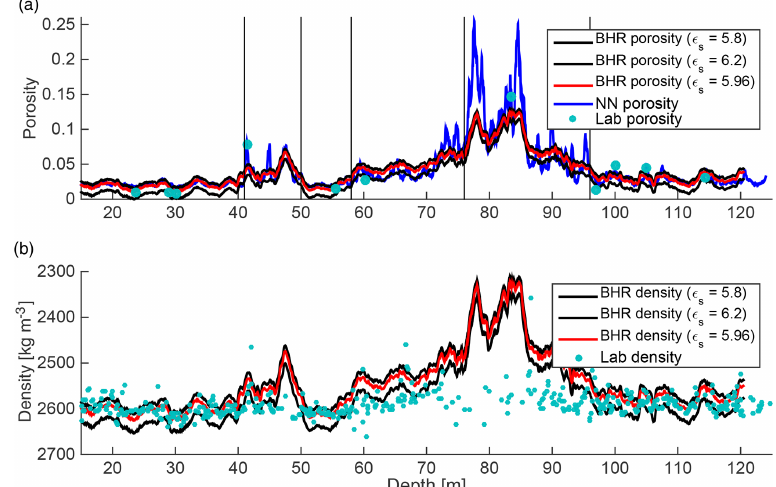
Figure 9. (a) Porosity estimates from BHR velocities for different dielectric permittivities of the solid material (cid:15) s and from neutron– neutron (NN) data compared with laboratory-based measurements for selected core samples (Jörg Renner, personal communication, 2016). (b) Inferred density from BHR porosities compared to Archimedes-type density measurements on the core samples (Jörg Renner, personal communication, 2016).